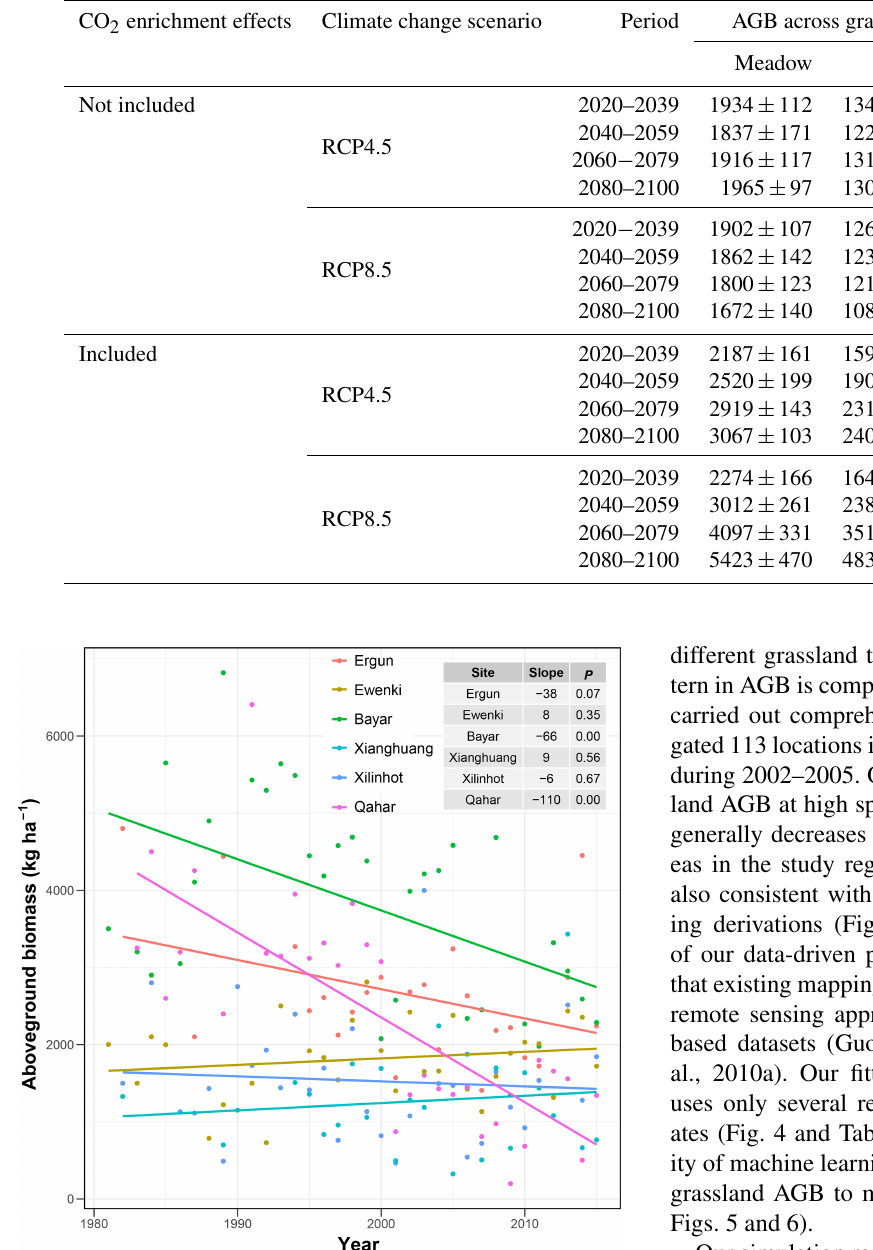
Table 2. Summary of Inner Mongolian grassland aboveground (AGB) biomass during different periods.